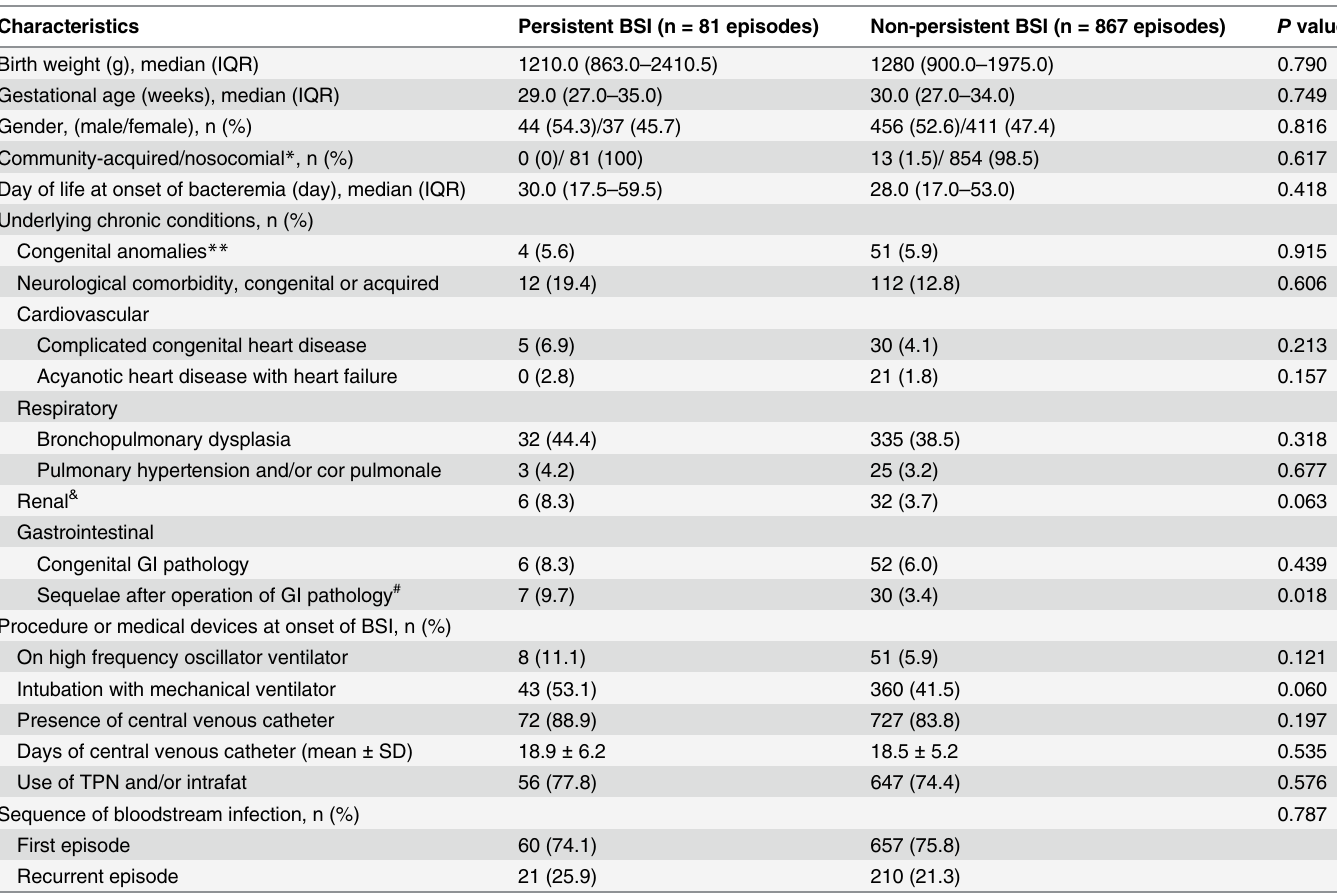
Table 2. Comparison of demographic characteristics between persistent and nonpersistent bloodstream infections (BSIs) in infants hospitalized in the neonatal intensive care